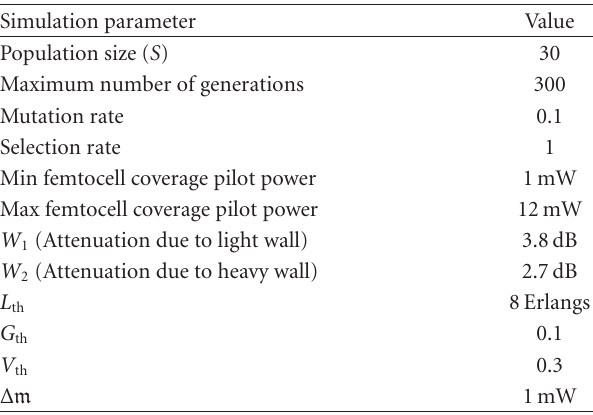
Table 1: Simulation parameters.